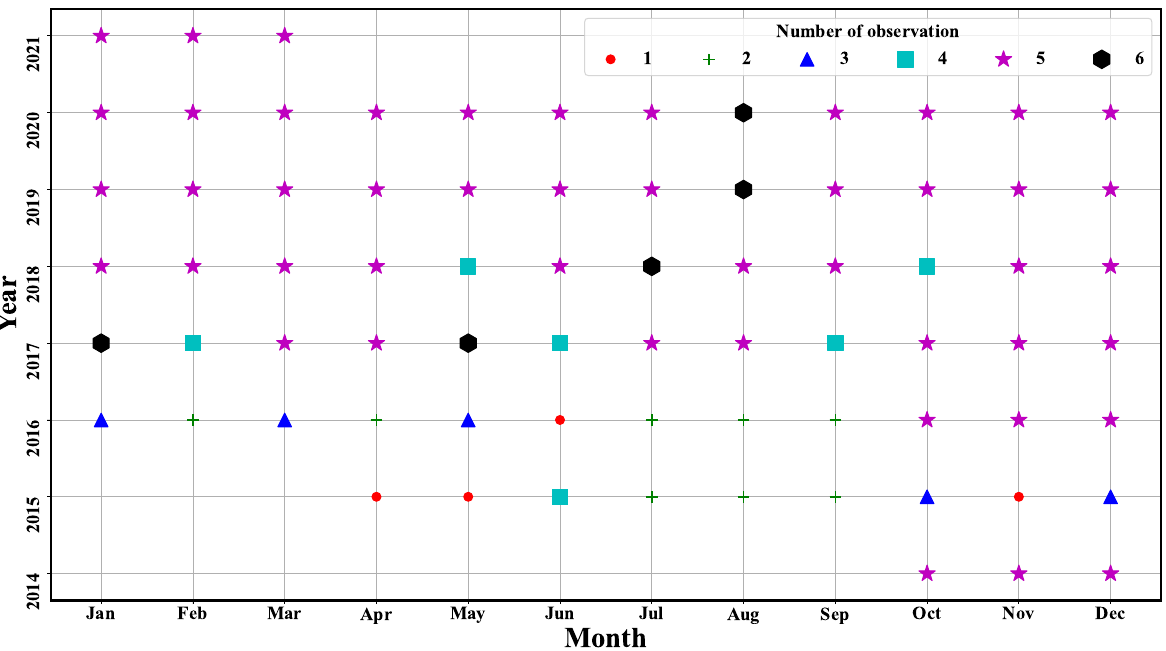
Figure 4. The temporal distribution and number of Sentinel-1 SAR observations per month between 2014 and